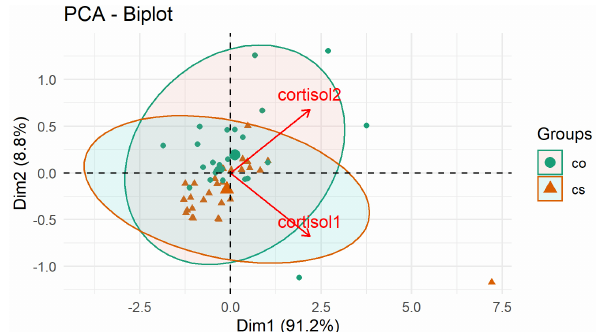
Fig. 1. PCA for cortisol in the experimental and non- intervention control groups (cs—the experimental cran- iosacral osteopathic therapy group, co—the control group). Table 1. Wilcoxon test of cortisol levels (C) before starting the study and after five weeks for the experimental craniosacral osteopathic (cs) group and the non-intervention control group (co). Groups Before vs. after p -value cs C1 vs. C2 0.3016 In Table 1, statistically significant difference in